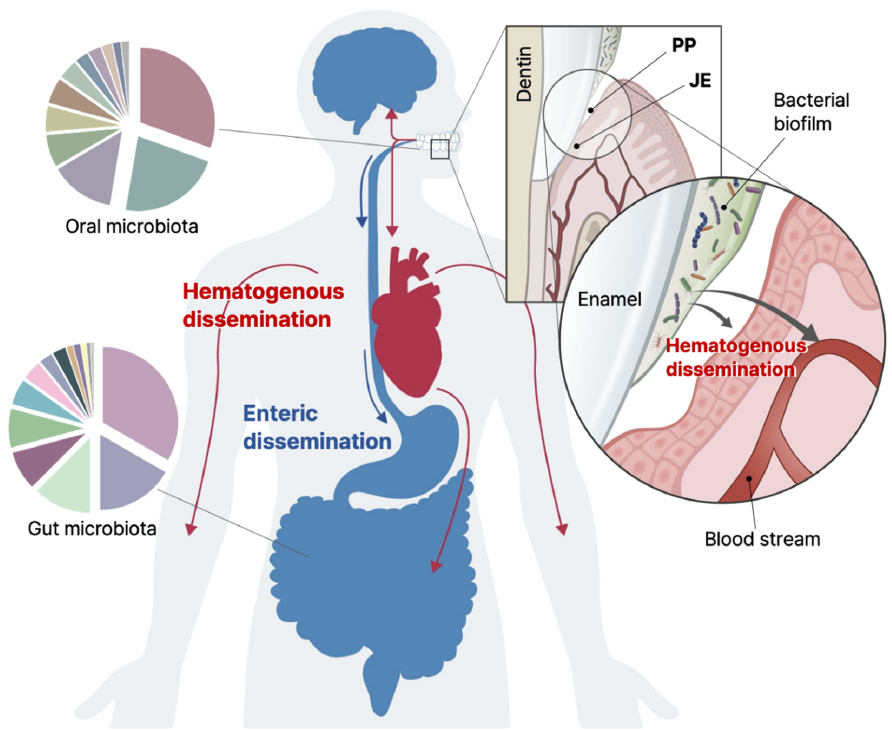
Figure 3. The oral cavity as the origin of the internal microbiome in humans. The microbiome in the